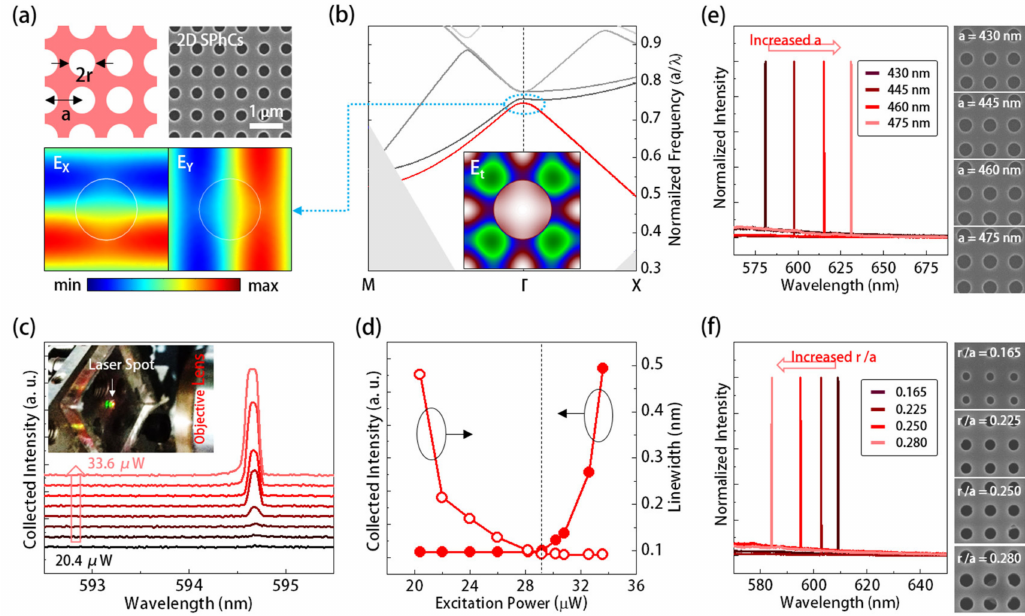
Figure 2. ( a ) Lattice parameters definitions of 2D SPhCs, theoretical E X and E Y field distributions of the Γ 1 BE mode using 3D FEM simulation, and top-view SEM picture of 2D SPhCs manufactured by the process in Figure 1b; ( b ) theoretical band diagram of 2D SPhCs with r / a of 0.25 on a dye-doped PMMA thin film with a t of 300 nm; the inset shows the theoretical E t field of Γ 1 BE mode by the PWE method for mode identification; ( c ) the measured spectra and ( d ) the corresponding lasing emissions/linewidths under different excitation powers; the inset of ( c ) further shows the picture of light emission from the dye-doped PMMA film with 2D SPhCs; and the measured lasing spectra and SEM images of 2D SPhCs with different ( e ) a and ( f ) r / a